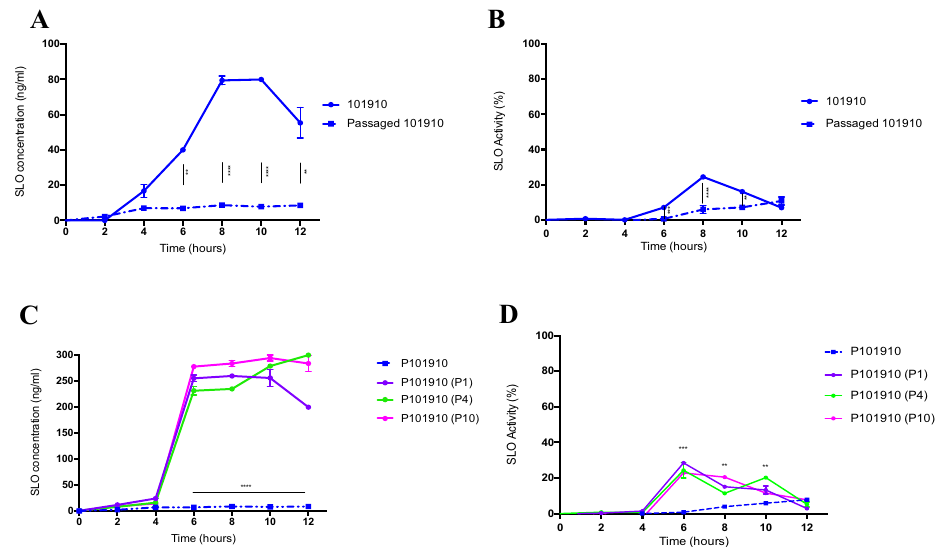
Figure 4. Comparison of streptolysin production and activity in emm type 1.0 grown in vitro or recovered from in vivo. ( A ) Concentration of streptolysin (ng/ml) secreted into the supernatant by emm type 1.0 (isolate 101,910) grown in vitro or recovered from knee joints (P101910) and then grown in vitro. ( B ) SLO haemolytic activity. ( C ) After subsequent in vitro passaging of in vivo recovered P101910 in Todd-Hewitt broth, the concentration of streptolysin (ng/ml) was measured, ( D ) and the SLO haemolytic activity. **p value < 0.01, ***p < 0.005 and ****p value < 0.001 two-way ANOVA followed by a Bonferroni’s multiple comparisons